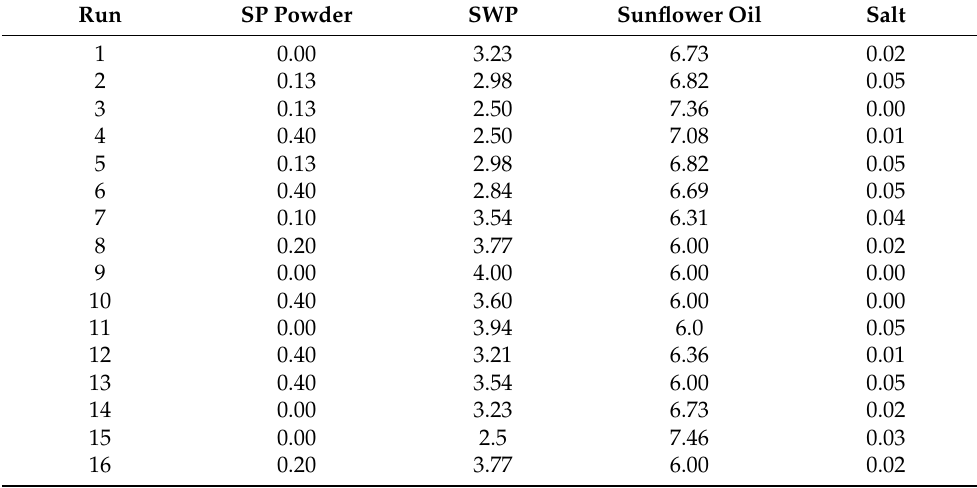
Table 1. D-optimal experimental design for the minimum and maximum levels